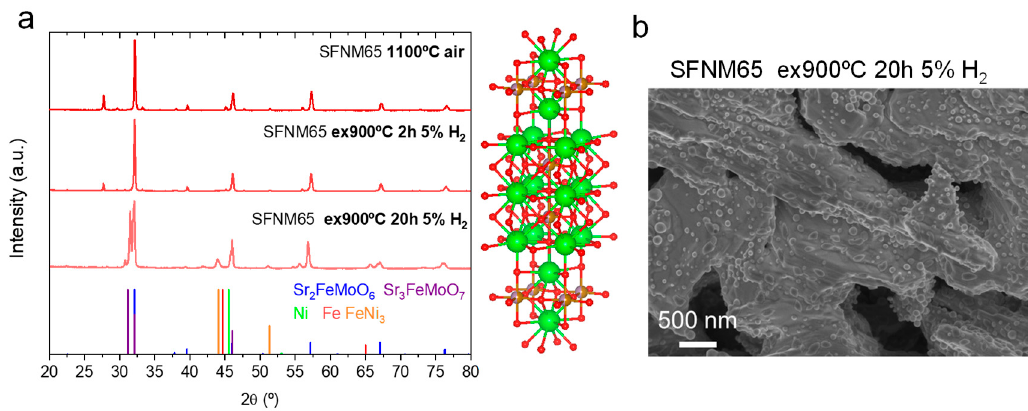
Figure 5. ( a ) Comparative of the XRD patterns of the SFNM65 material as-synthesized, and after 2 h and 20 h exsolution at 900 °C in a 5% H 2 atmosphere. Crystal structure of a Sr 3 FeMoO 7 Ruddlesden–Popper phase. Green, brown, and red spheres represent Sr, Fe/Mo, and oxygen atoms, respectively. Structure drawn with VESTA [37]. ( b ) SEM image of the SFNM65 material after 20 h exsolution. Fe and Ni reflections are shown in ( a ) for the sake of comparison.